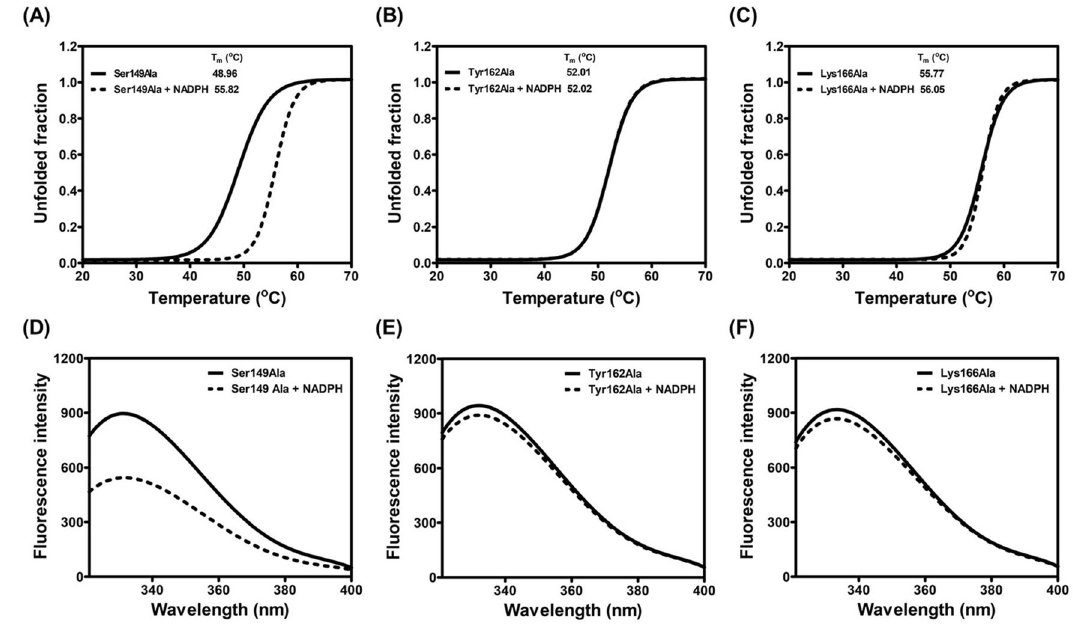
Figure 7. Cofactor binding analysis of BPSS2242 mutants. ( A , B , and C ) Thermal denaturation upon NADPH binding and ( E , F , and G ) the emission spectra of purified proteins in the absence and presence of